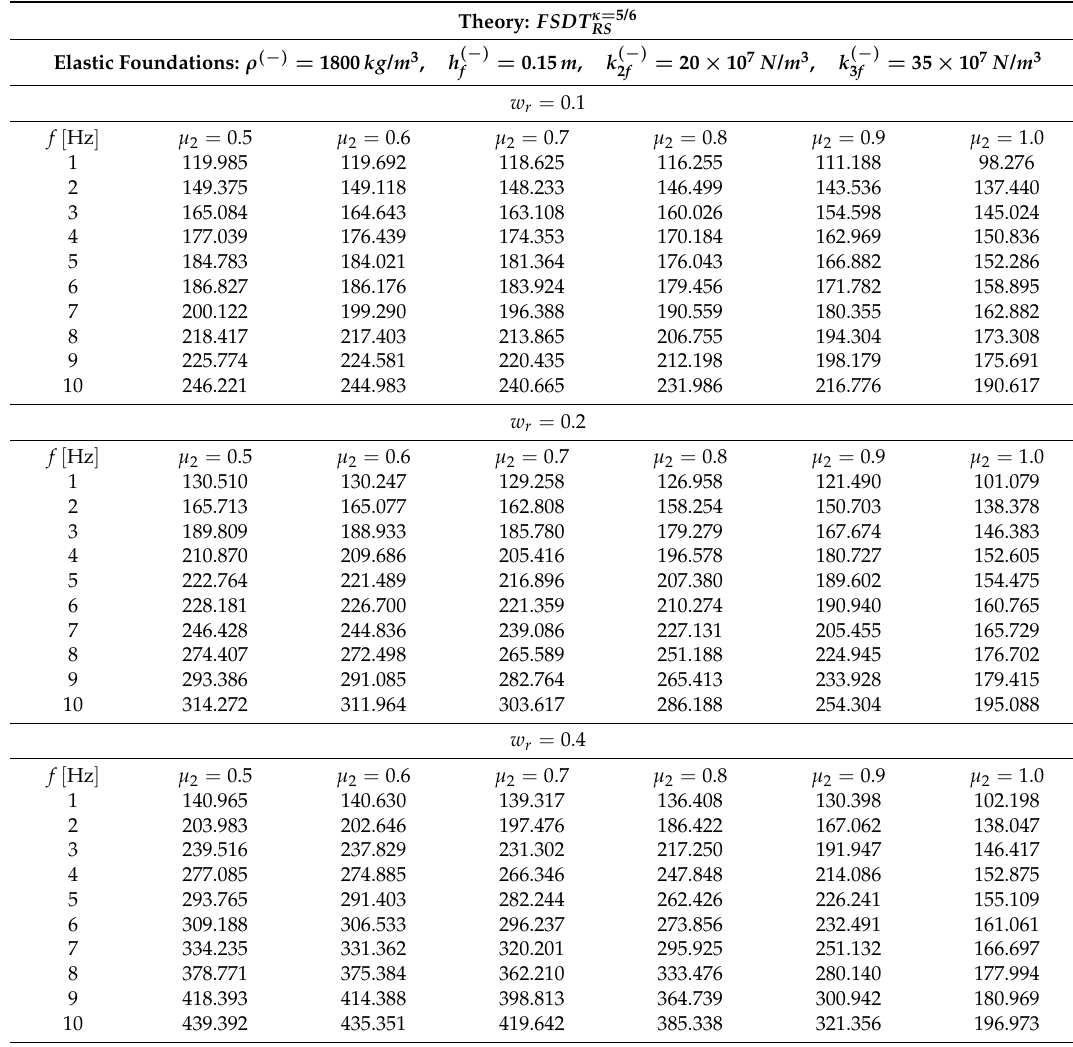
Table 15. First ten natural frequency variations for FSDT κ = 5/6 (Figure 4c) reinforced by CNTs distributed as ing Figure 5c for different mass fractions w r when varying the parameter of agglomeration µ 2 with µ 1 = 0.5. The Chebyshev-Gauss-Lobatto grid distribution was employed, with I N = 31, I M =